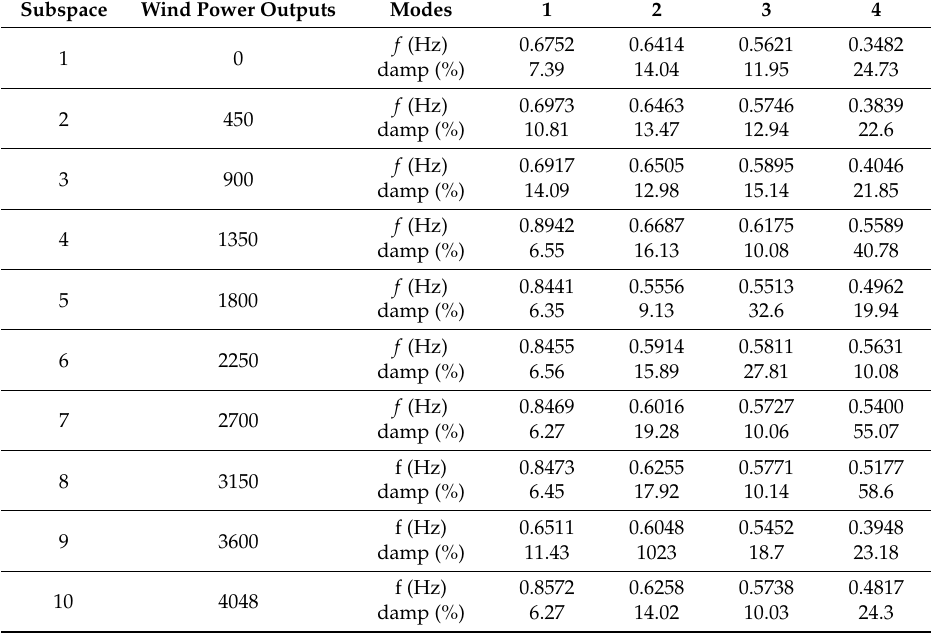
Table 1. Damping ratio and frequency of inter-area modes with